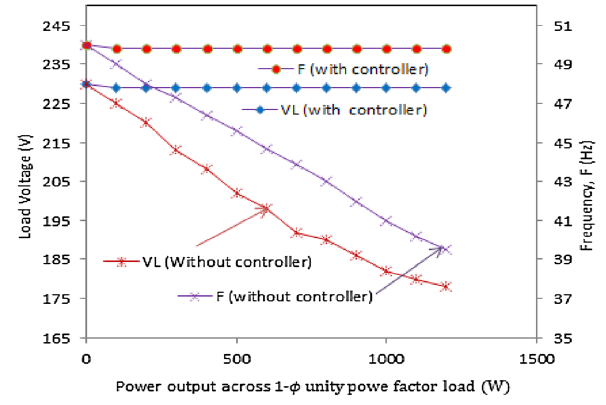
Fig. 17 Comparison of outcomes attained for load voltage and fre- quency with and without EGLC controller